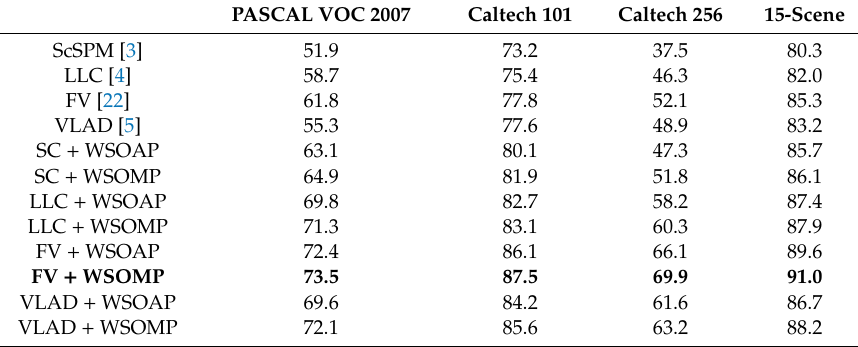
Table 1. Classification accuracy (MAP in %) of the weighted second-order pooling scheme integrating with the bag-of-visual-words (BoVW) baseline encoding methods. FV: Fisher Vector, VLAD: Vector of Locally Aggregated Descriptor, WSOAP: weighted second-order average pooling, WSOMP: weighted second-order pooling.